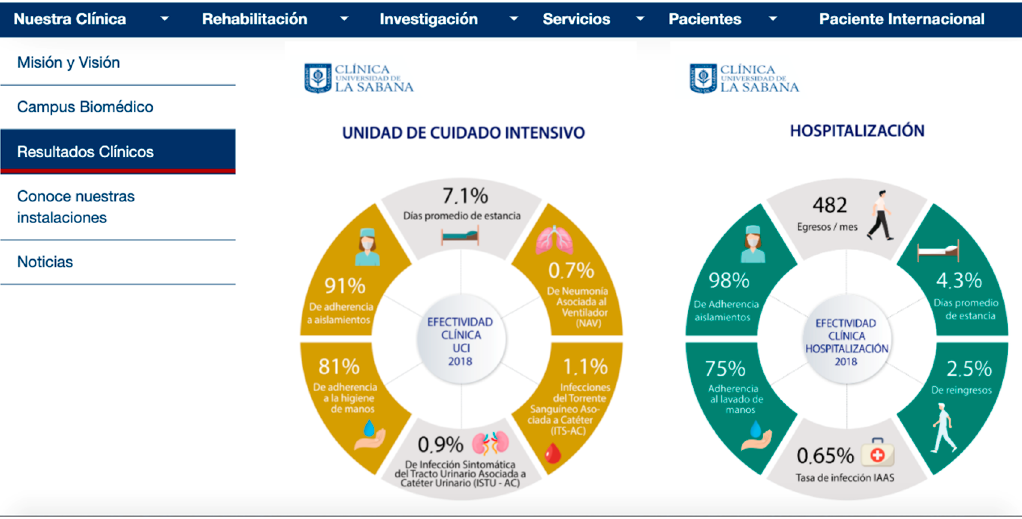
Figure 4. Representation of “Information offered” variable with indicators related in number of hospitals accomplishing them.